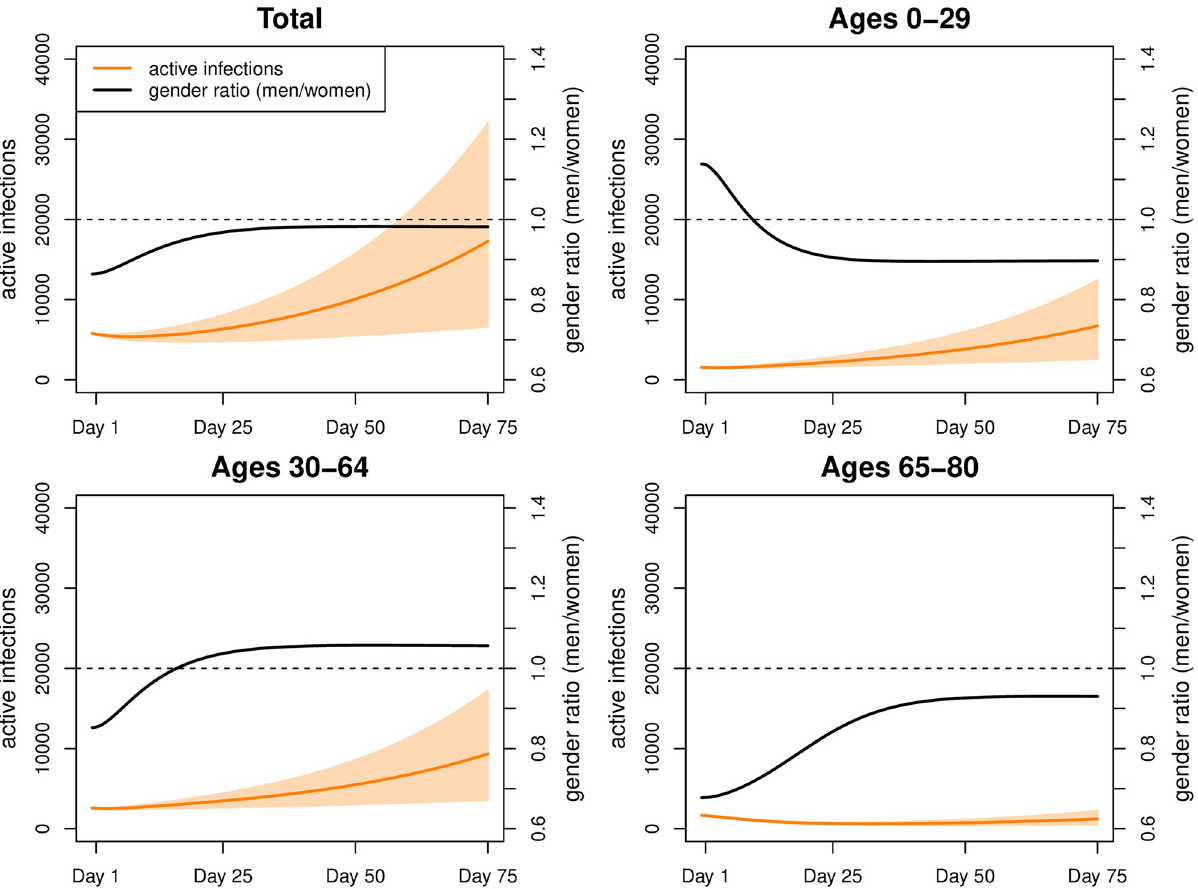
Fig 8. Simulation results for Scenario 3. Number of active infections and gender ratio (men/women) in Scenario 3 (intervals represent 80% range due to parameter uncertainty).